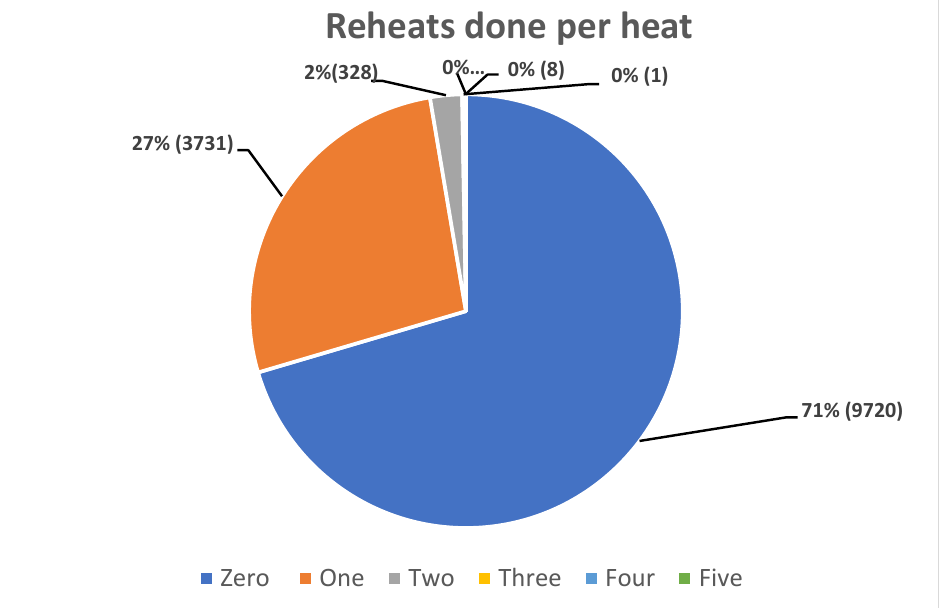
Figure 7. Pie chart representing the number of episodes per number of times reheating was done during the episode.